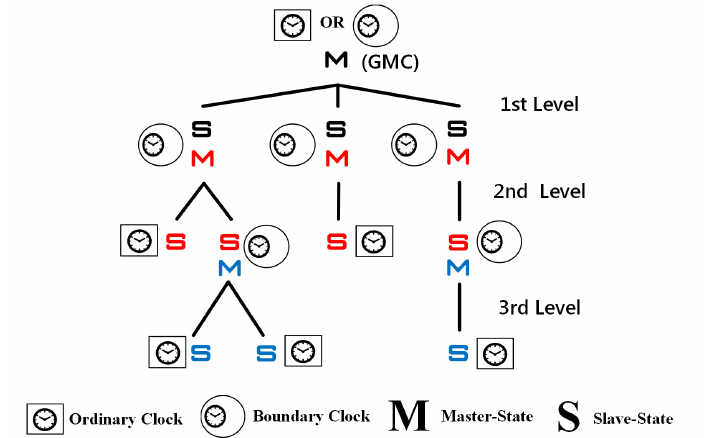
Figure 1. Example of the PTP master–slave synchronization hierarchy. PTP: Precision Time Protocol; GMC: grandmaster